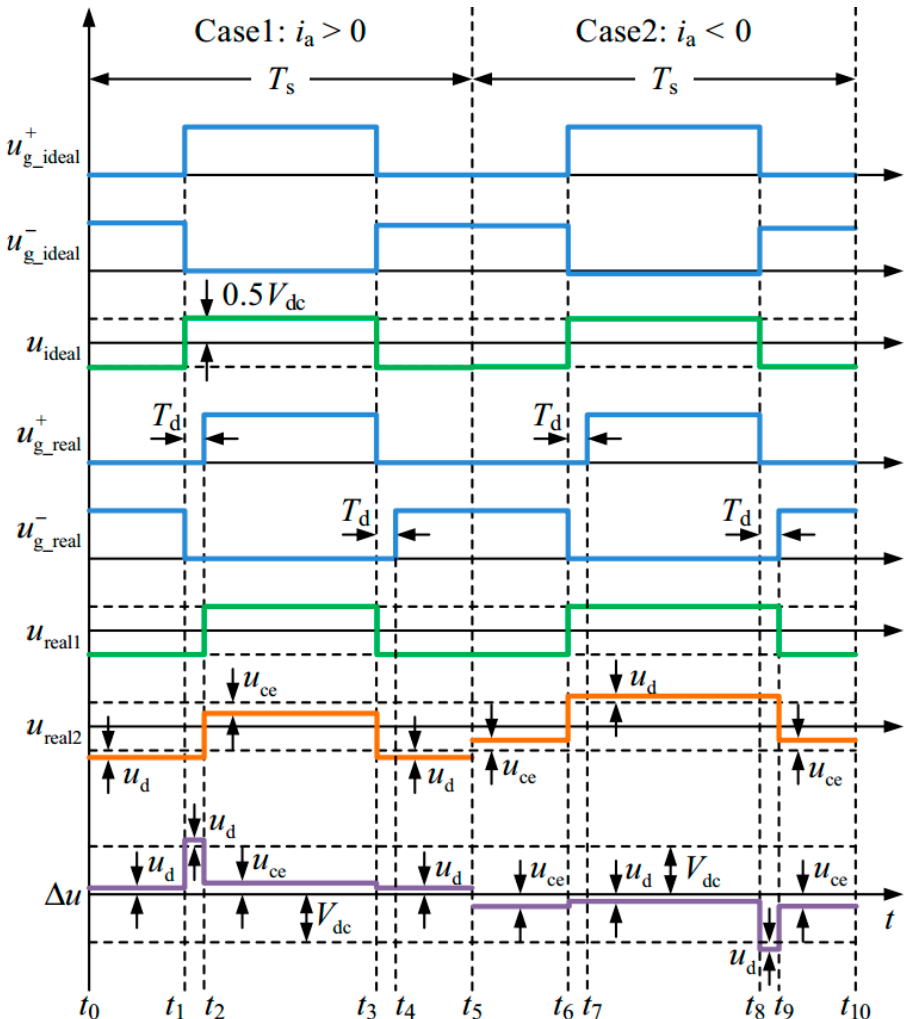
Figure 5. Illustration of voltage waveforms and gate signals [21] .